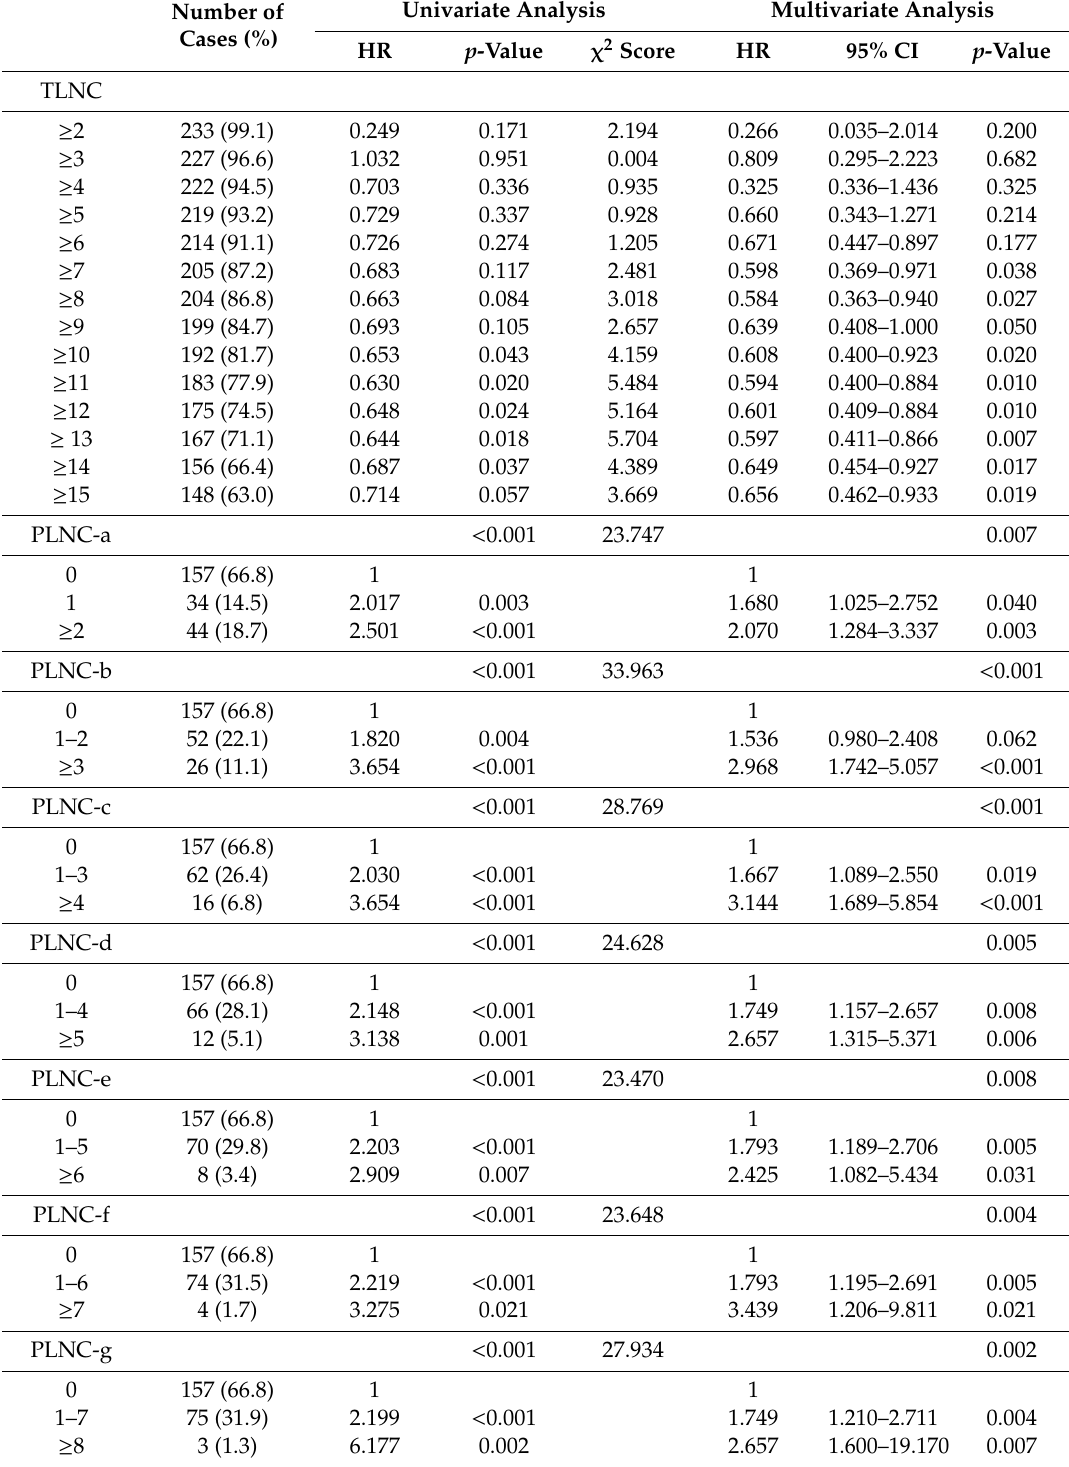
Table 3. Comparison for cuto ff values of each total lymph node count (TLNC), positive lymph node count (PLNC), and lymph node ratio